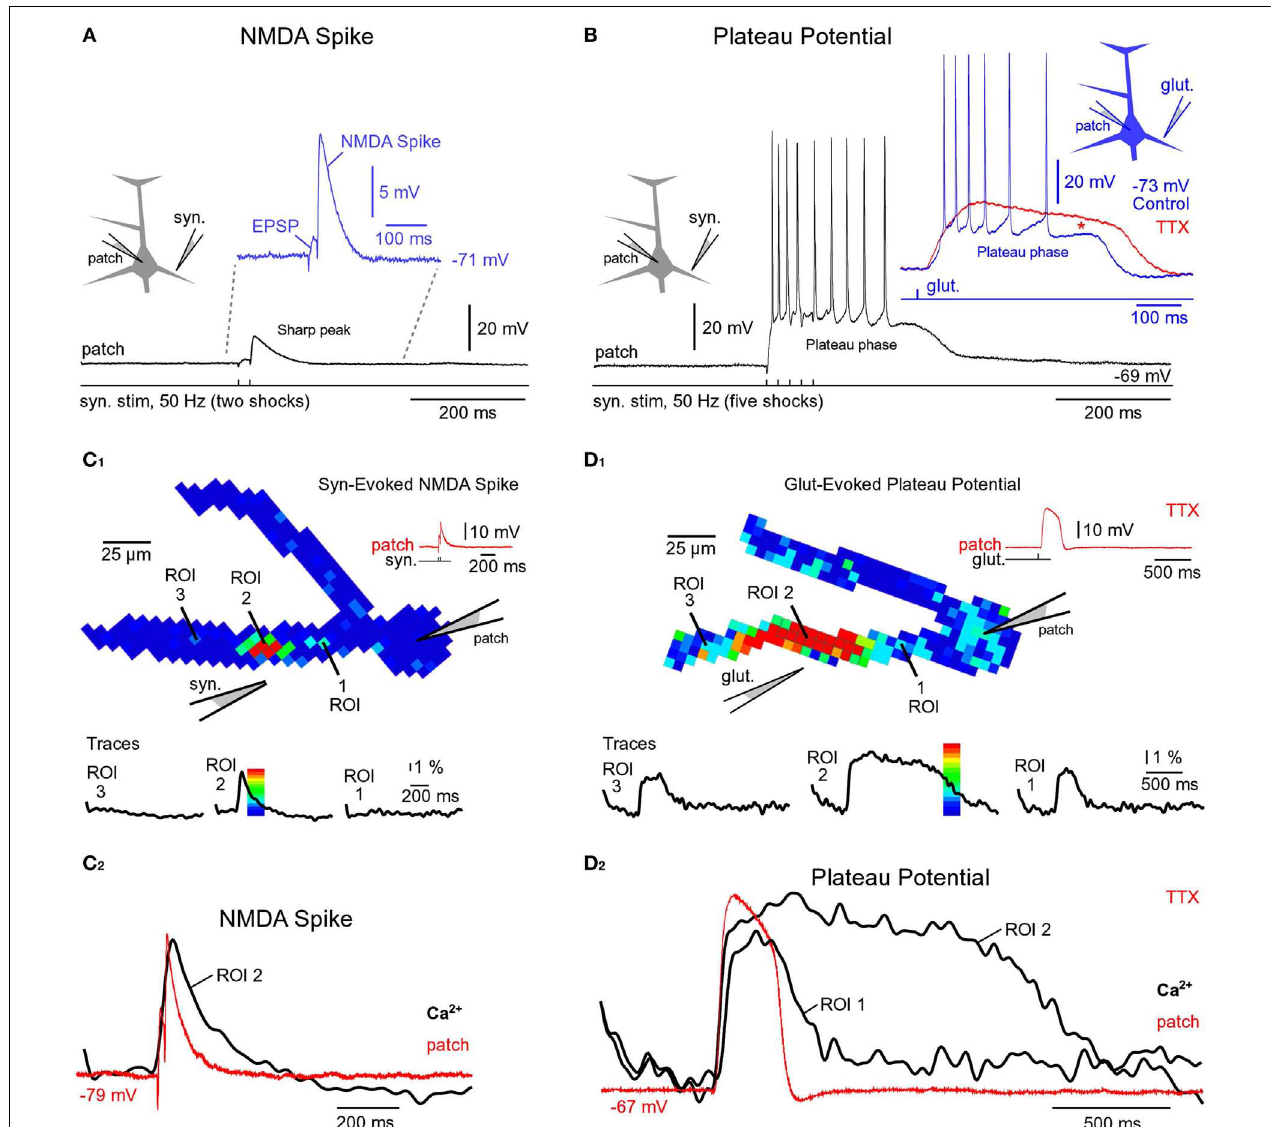
transients in two basal dendrites at the peak of the synaptically evoked NMDA spike. Ca 2 + signal amplitude is color-coded according to the scale shown superimposed on the trace.Traces: three ROIs (5–8 pixels spatially averaged) were selected for display. Note that Ca 2 + transient is absent from dendritic segments proximal (ROI 1) and distal (ROI 3) to the synaptic input site (ROI 2). (C 2 ) Somatic whole-cell recording (red) and dendritic calcium signal (black) are copied from (C 1 ) and superimposed. (D 1 ) Same as in (C 1 ) , except glutamate iontophoresis (5ms) was used to trigger dendritic plateau potential (duration ∼ 300ms). Robust Ca 2 + transients are present proximally and distally to the glutamate input site (ROI 2). Note that Ca 2 + transients in ROI 1 and ROI 3 have different temporal dynamics than the transient obtained at the glutamate input site (ROI 2). (D 2 ) Same as in (C 2 ) except signals copied from (D 1 )